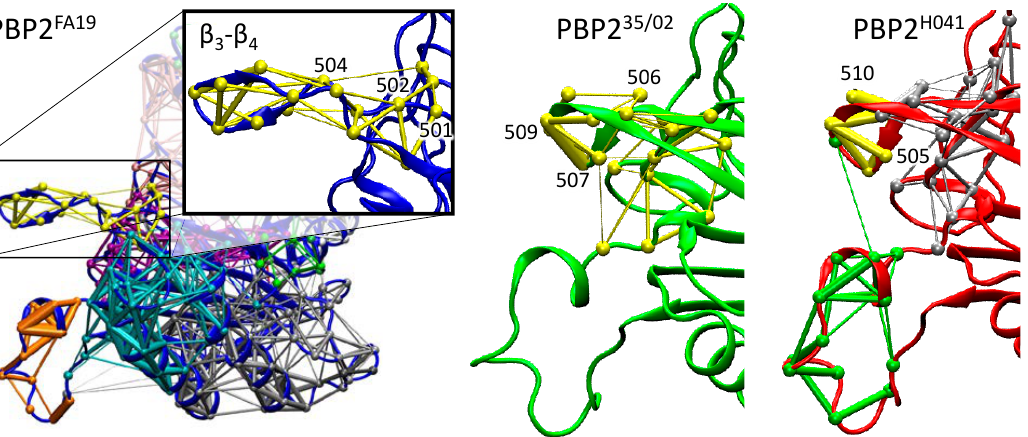
Figure 5. Communities obtained in dynamical network analysis of 500 ns trajectories of PBP2 FA19 (blue), PBP2 35/02 (green) and PBP2 H041 (red); the loop β 3 - β 4 is highlighted. Edges of communities are shown in sticks, and nodes are shown as balls. Edges and nodes from the same community are colored same.